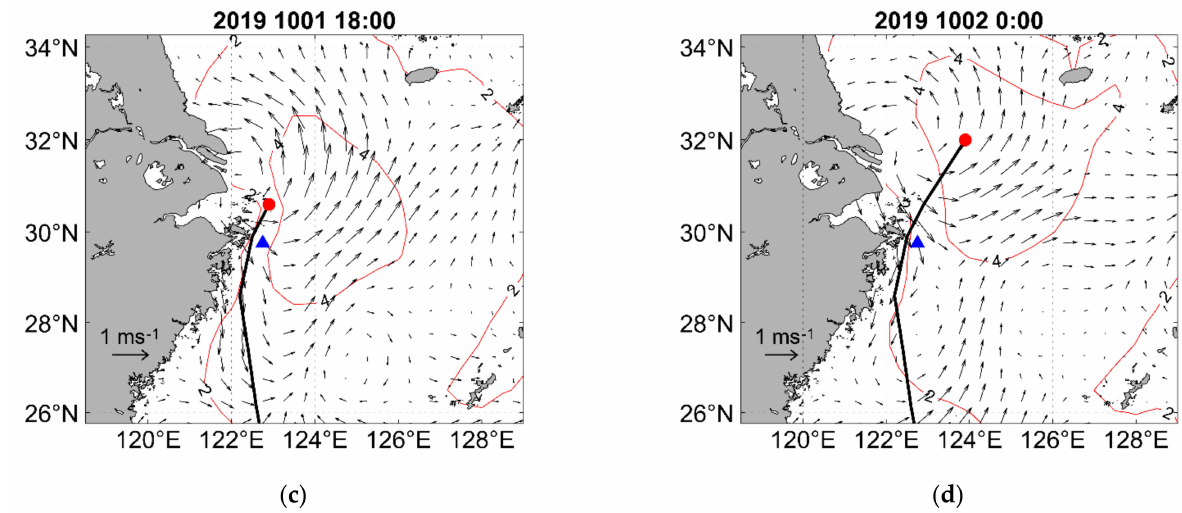
Figure 14. The significant wave height of Zhoushan sea area (red contour) at different times. ( a ) 0:00 on 1 October. ( b ) 12:00 on 1 October. ( c ) 18:00 on 01 October. ( d ) 0:00 on 2 October. (The vectors represent currents, the black line represents “MITAG” track, the red circle is typhoon center, and the triangle is the location of Zhoushan buoy.)